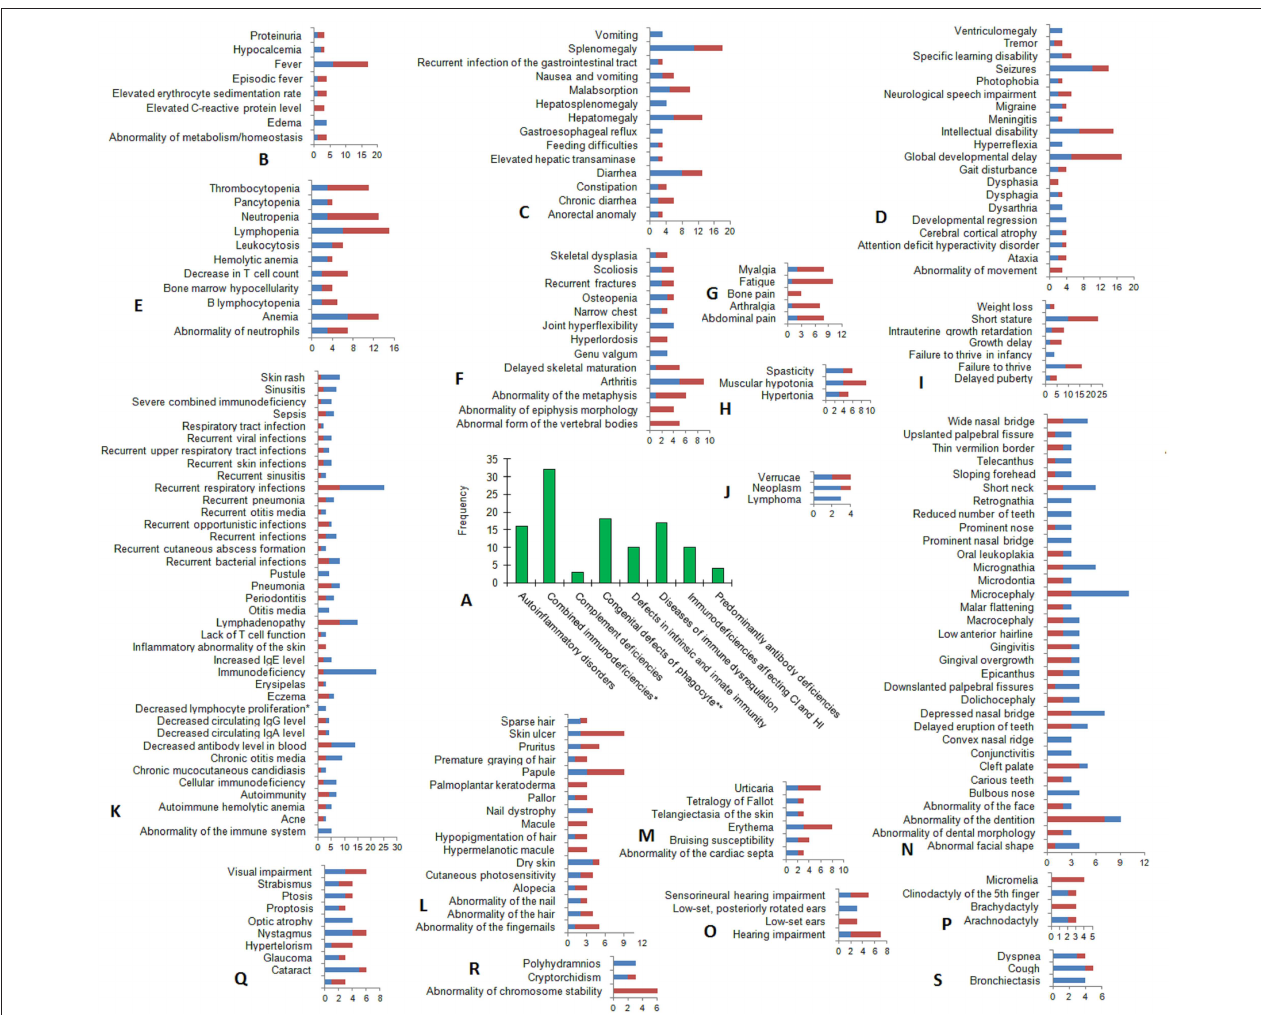
FIGURE 3 | Frequent and very frequent clinical signs and symptoms in diseases matched between IUIS and ORPHANET. (A) The distribution of diseases within the IUIS categories (for 110 diseases with available annotations on symptom frequency). (B–S) The frequency of occurrence (X-axis) of frequent (dark red) and very frequent (blue) clinical signs and symptoms (Y-axis) is mapped to HPO term names within top-level HPO categories: (B) Metabolism/Laboratory abnormality, (C) Digestive System, (D) Nervous System, (E) Blood and blood-forming tissues, (F) Skeletal system, (G) Constitutional Symptom, (H) Musculature, (I) Growth, (J) Neoplasm, (K) Immunology, (L) Skin, Hair, and Nails, (M) Cardiovascular, (N) Head and neck, (O) Ear, (P) Limbs, (Q) Eye, (R) Miscellaneous: Genitourinary system (Cryptorchidism), Prenatal and Birth (Polyhydramnios) and Cellular phenotype (Abnormality of chromosome stability), (S) Respiratory System.